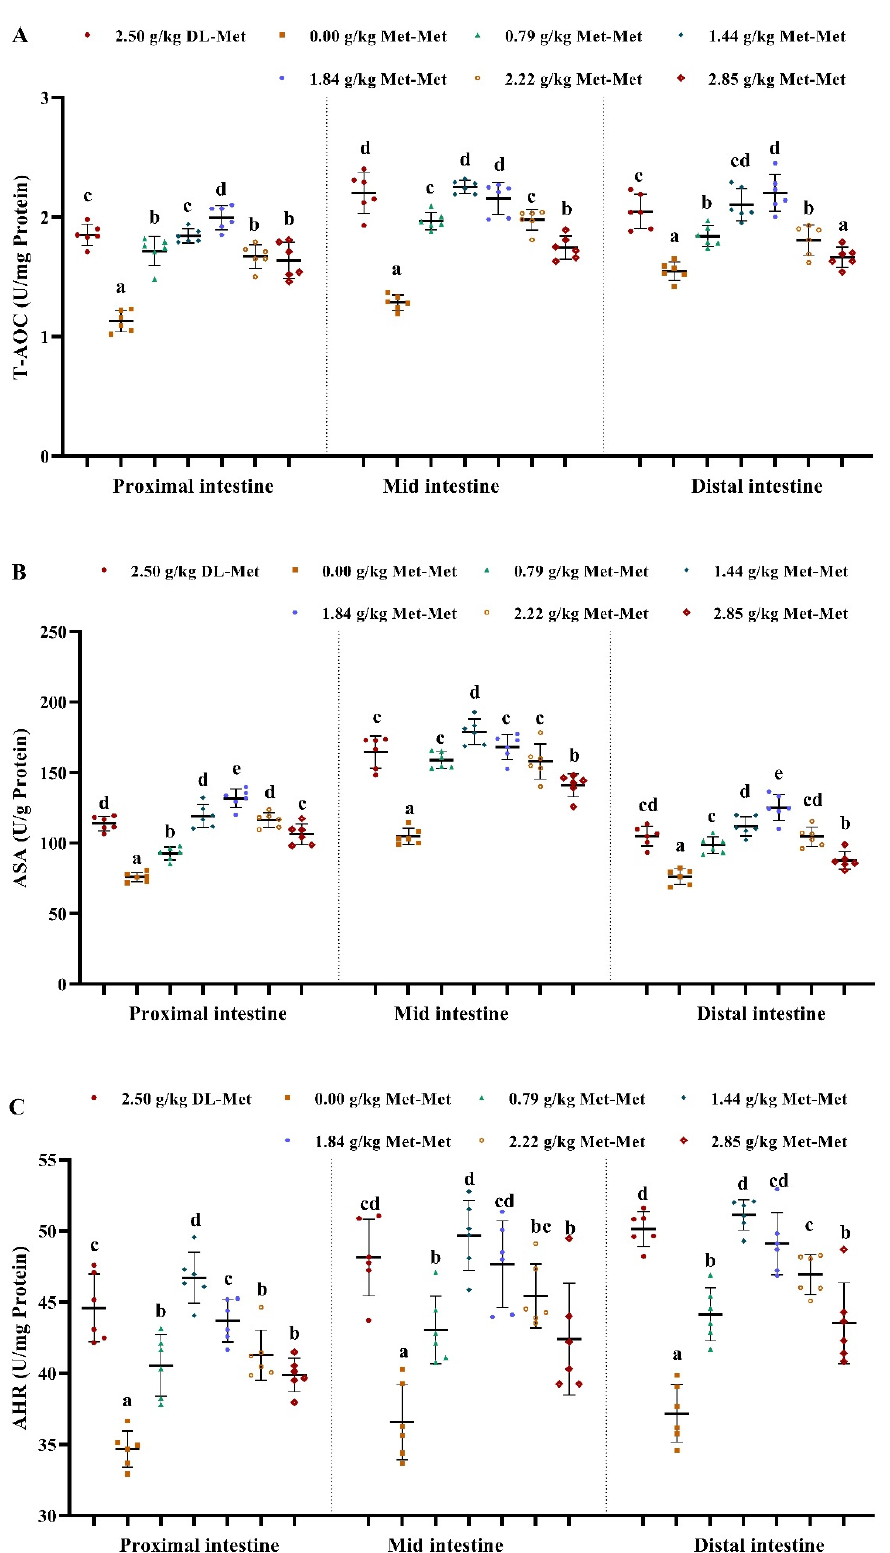
Figure 2. Effects of dietary DL-Met and Met-Met supplementation on total antioxidant capacity (T-AOC, ( A )), anti-superoxide anion activity (ASA, ( B )), and anti-hydroxyl radical activity (AHR, ( C )) in three intestinal segments of juvenile grass carp. Data represent means of six fish in each group, error bars indicate S.D. a, b, c, d, e within a column, means without a common lowercase superscript differ ( p <